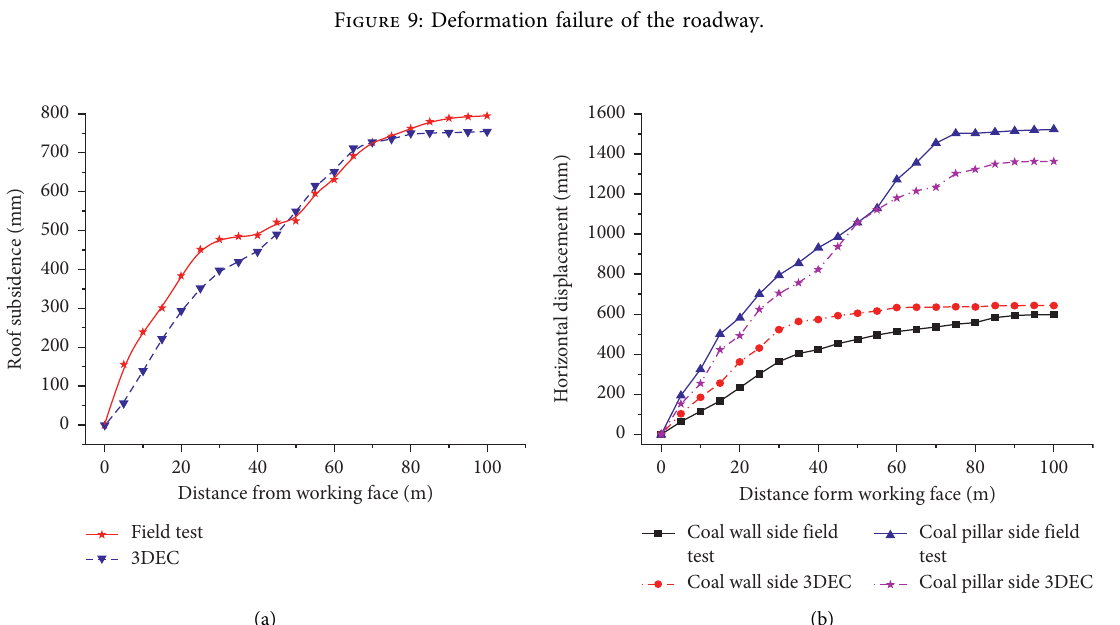
Figure 10: Displacement comparison of the roadway surrounding rock. (a) Roof subsidence curve. (b) Displacement curve of roadway two sides.